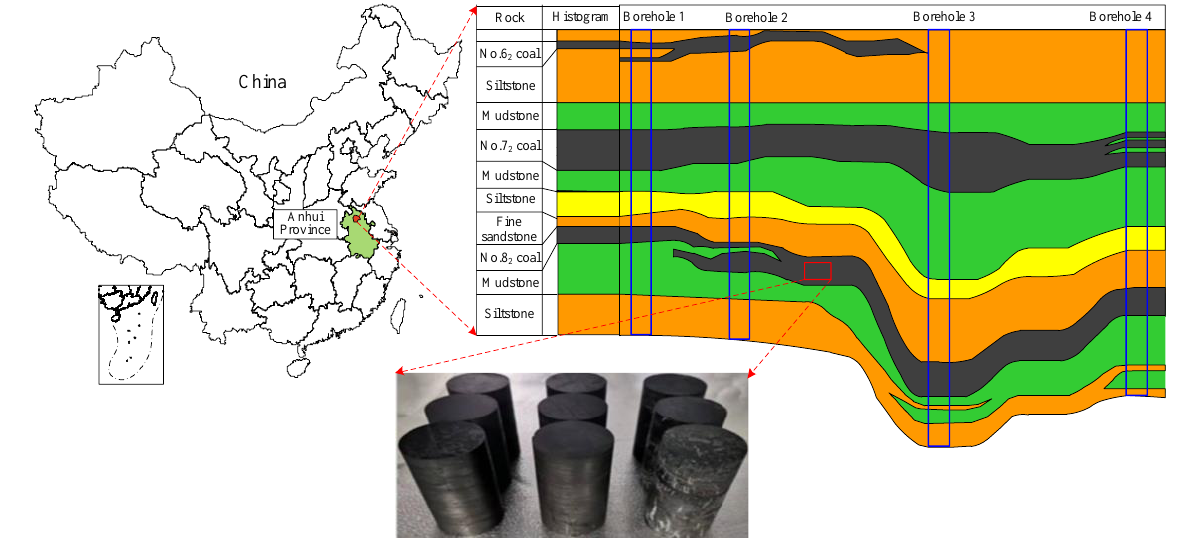
Figure 1. Schematic diagram of sampling points of coal samples.